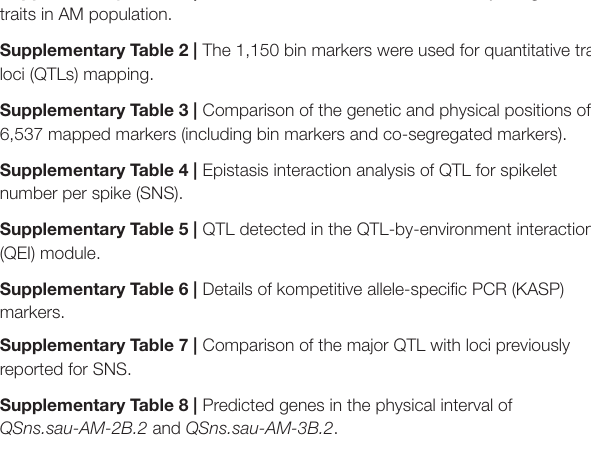
Supplementary Table 1 | Environmental information of the surveyed agronomic traits in AM population.